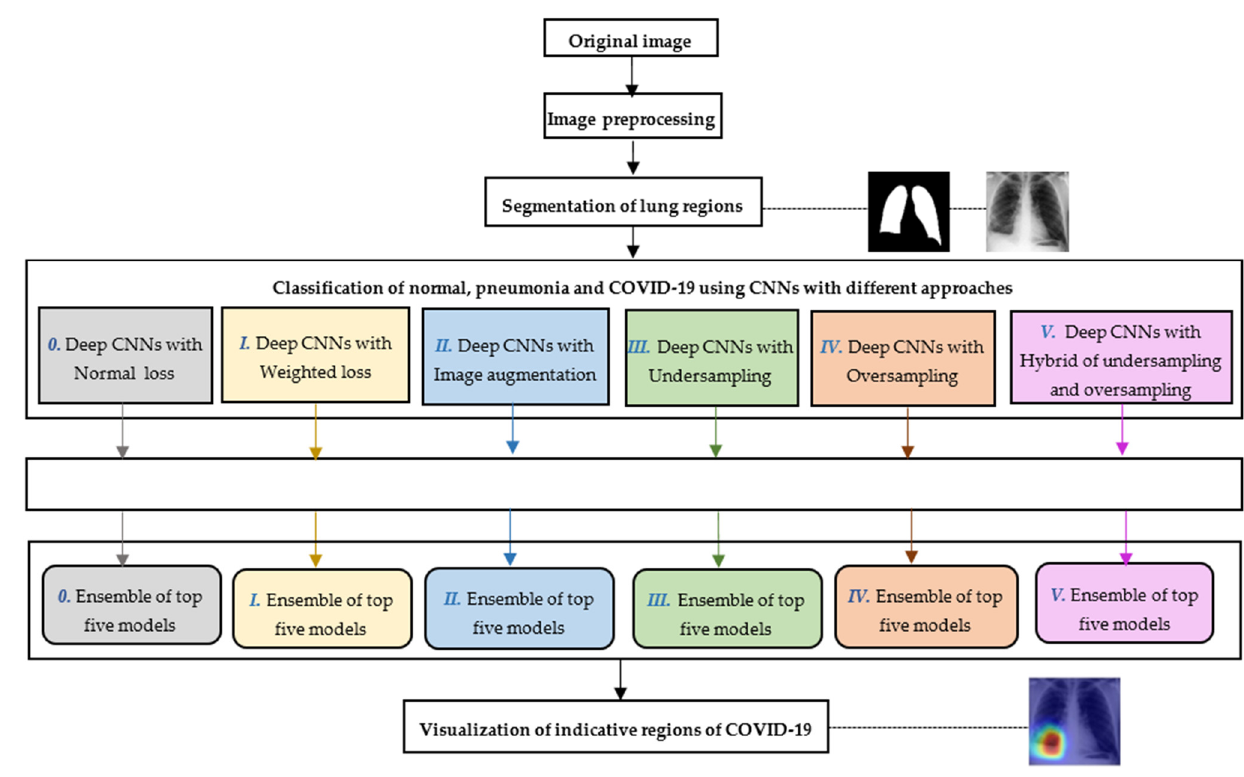
Figure 3. Block diagram of the proposed study.